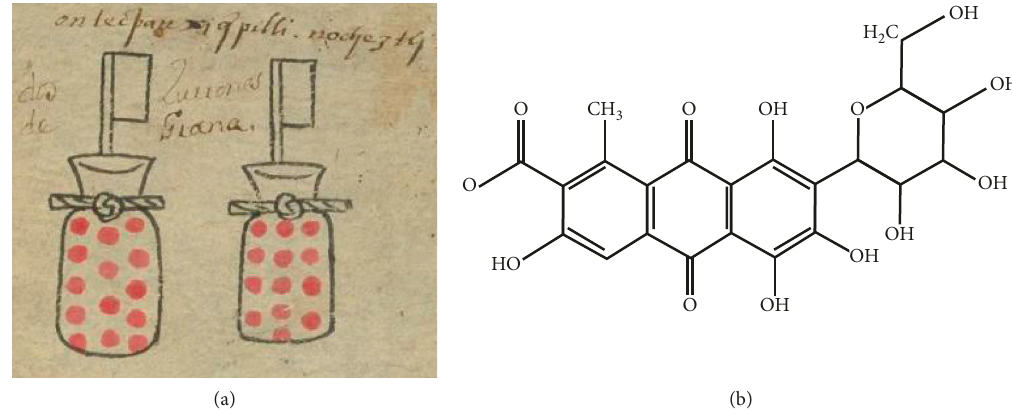
Figure 2: (a) Representation in codex of the pre-Columbian dye Nocheztli (http://www.wdl.org/es/item/3248/) and (b) molecular structure.